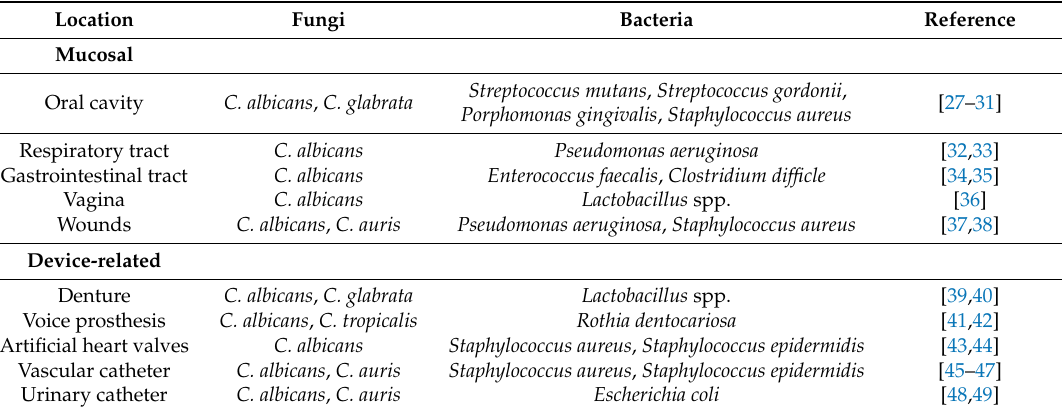
Table 1. Mucosal and medical-devices associated Candida biofilm